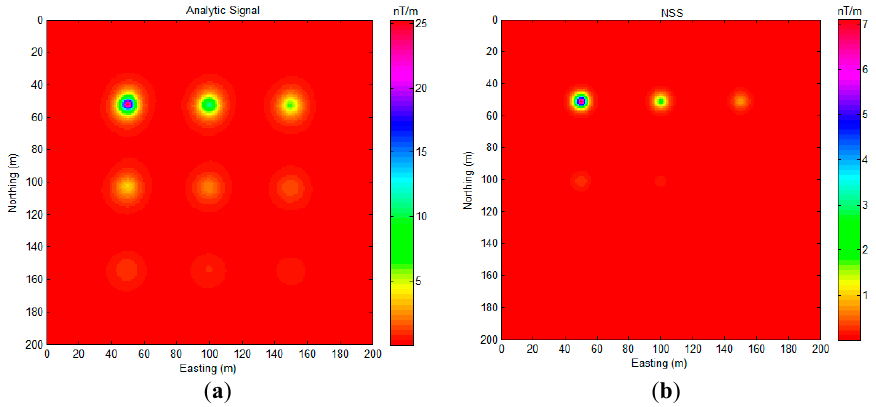
( a ) ( b ) ( b ) Figure 6. Total field anomaly ( a ) ( = 40 = 10 I D   ， ) and MDTA map ( b ). Black text in ( b ) Figure 6. Total field anomaly ( a ) ( I = 40 ◦ , D = 10 ◦ ) and MDTA map ( b ). Black text in ( b ) represents Figure 6. Total field anomaly ( a ) ( = 40 = 10 I D   ， ) and MDTA map ( b ). Black text in ( b ) =α =α represents the coordination of detected magnetic dipole locations, 0 . the coordination of detected magnetic dipole locations, α = 0. Figure 6. Total field anomaly ( a ) ( = 40 = 10 I D   ， ) and MDTA map ( b ). Black text in ( b ) represents the coordination of detected magnetic dipole locations, 0 . =α represents the coordination of detected magnetic dipole locations, 0 .